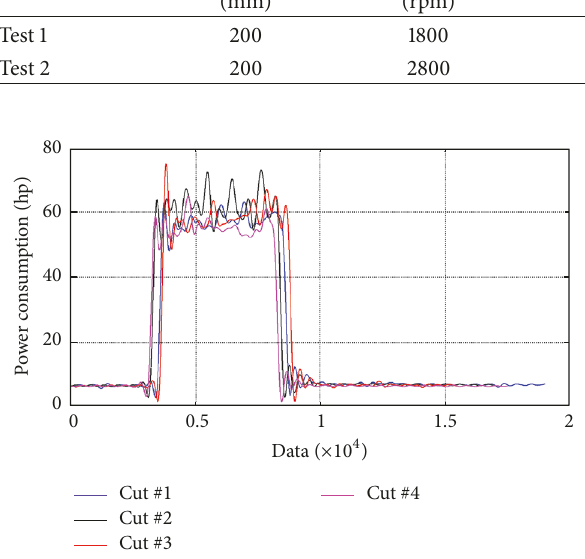
Figure 4: Measured power consumption during cutting, tests at 1800 rpm.